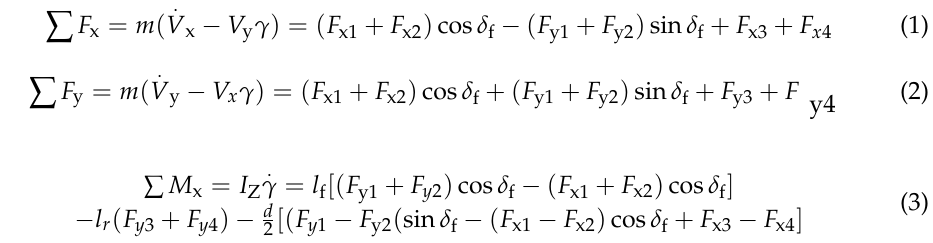
Among them, F xi and F yi are calculated according to the magic formula tire model.